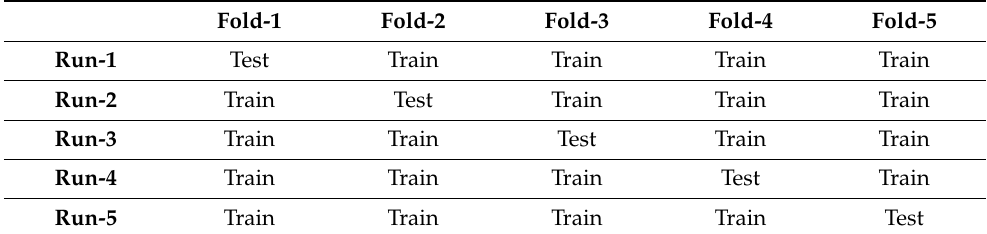
Table 2. The scenario of 5-Fold